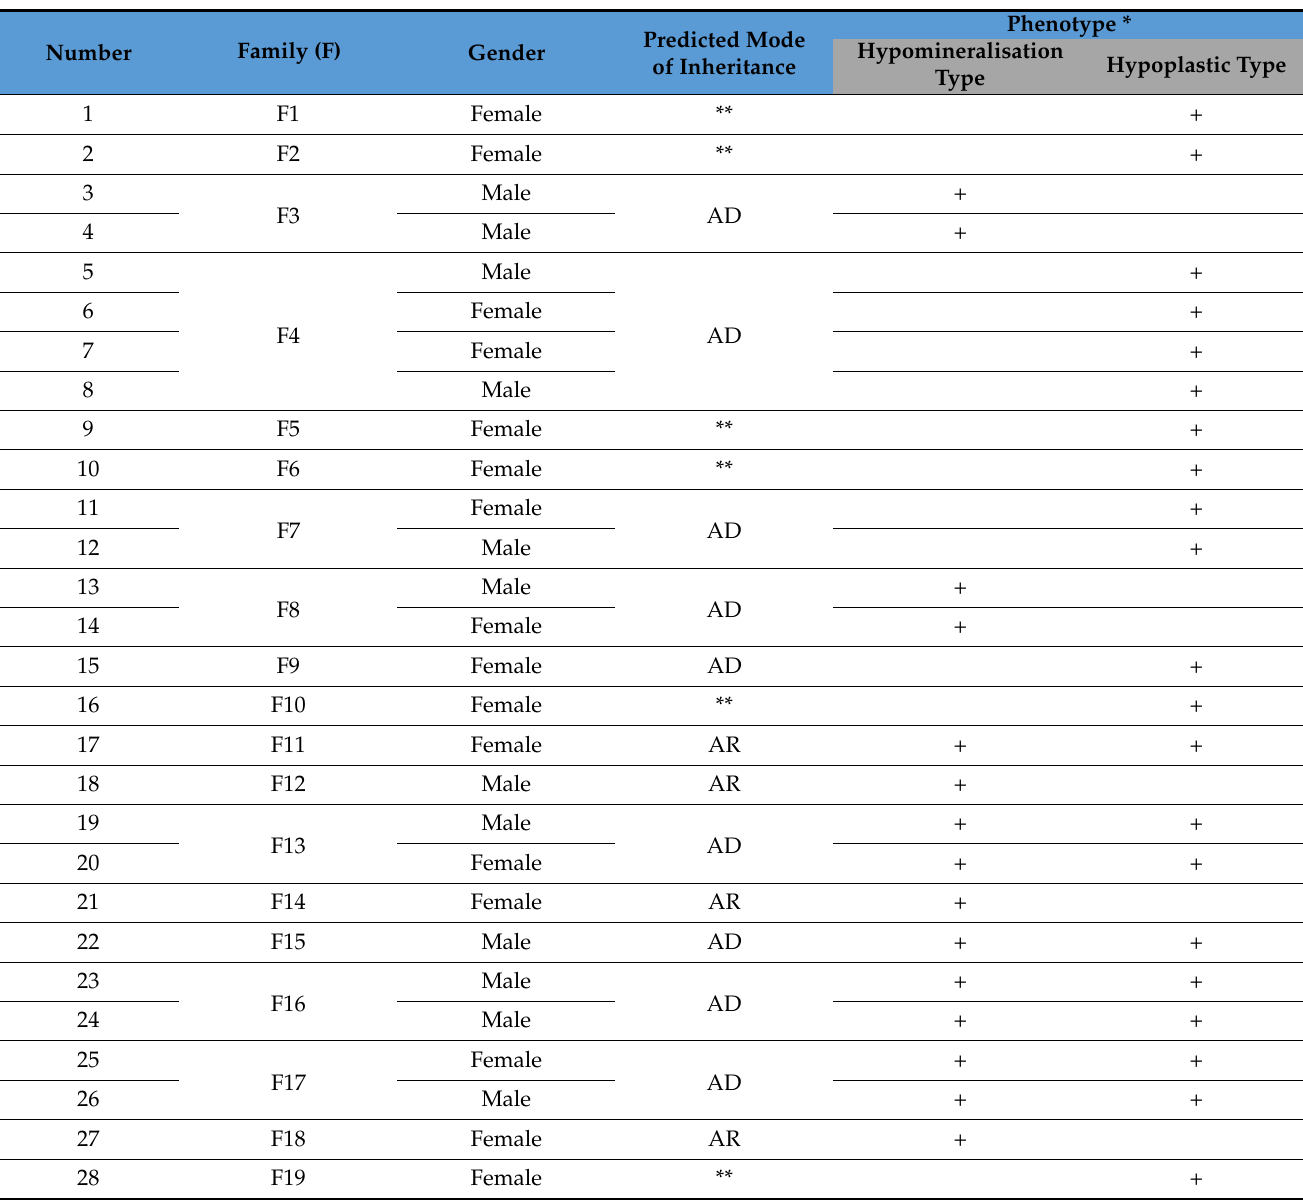
Table 1. Clinical characteristics of all referred AI patients in the period between 2000 and 2020. Patients included in further analysis are highlighted in